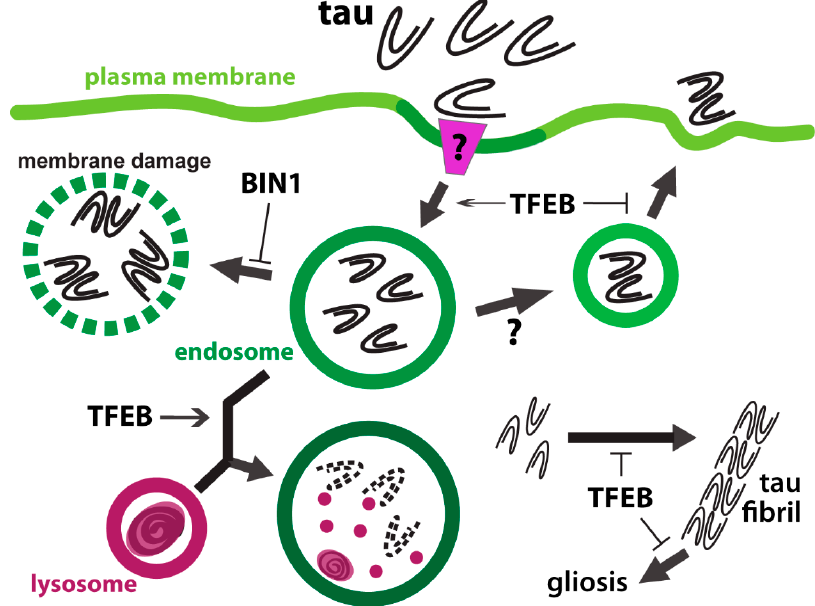
Figure 2. Endolysosomal processing of tau in astrocytes. Extracellular tau monomers and aggregates are endocytosed by astrocytes. Loss of BIN1, an Alzheimer’s disease-associated protein, promotes internalization and accumulation of tau aggregates in endosomes, and causes endomembrane damage. TFEB mediates multiple aspects of astrocytic clearance of tau. Uptake and lysosomal